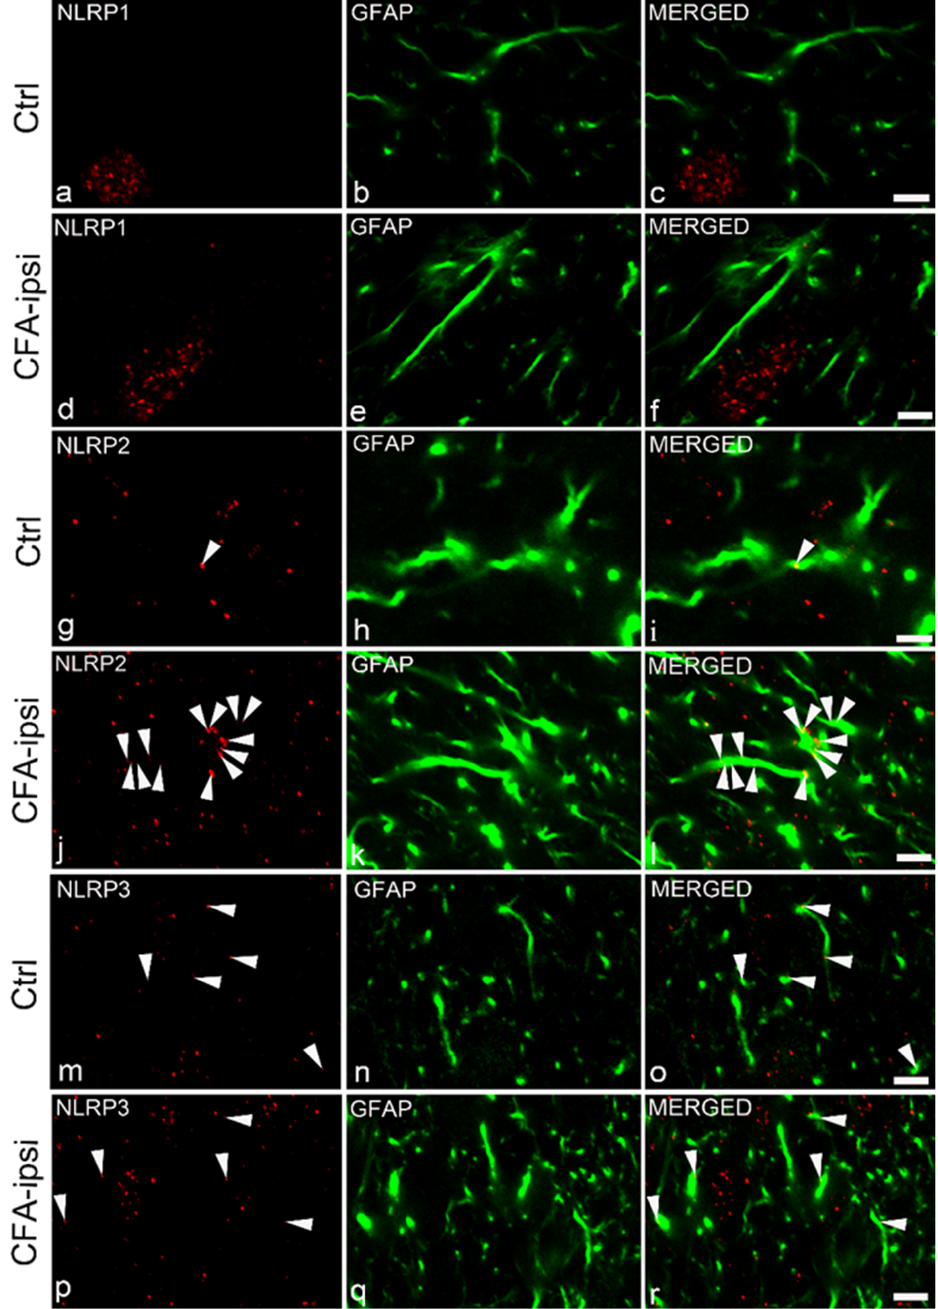
Figure 5. Astrocytic inflammasome expression during CFA-evoked inflammatory pain. Micrographs of single 1 µ m thick laser scanning confocal optical sections illustrating the putative co-localization between immunolabeling for NLRP1 (red; a – d ), NLRP2 (red; g – j ), NLRP3 (red; m – p ) and the immunoreactivity of astrocytes (GFAP, green; b , e , h , k , n , q ) in the superficial spinal dorsal horn. Mixed colors (yellow; marked by white arrowheads) on the superimposed images ( c , f , i , l , o , r ) indicate double-labeled structures. For each inflammasomal marker, the first row of the images are taken from control samples (Ctrl), whereas the second row of images represents chronic inflammation (CFA-ipsi). Spinal astrocytes dominantly express NLRP2 (and to a lesser extent, NLRP3) inflammasomal markers, whilst there is a total segregation between NLRP1 and GFAP labeling. Scale bars: 5 μ m.